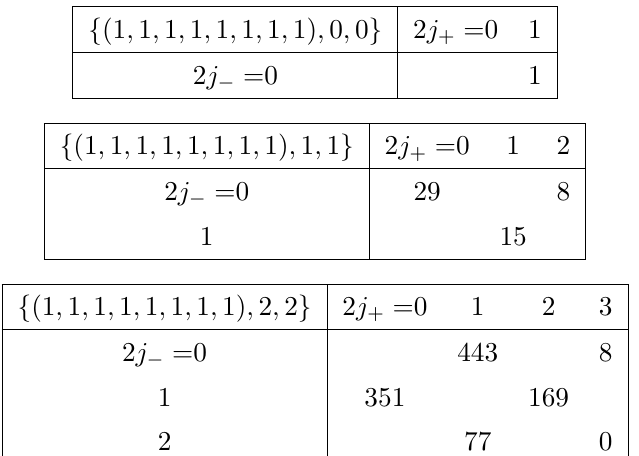
Table 14 . Refined GV invariants from (2,0) E 8 SCFT at base degree (1,1,1,1,1,1,1,1), fiber degree 0, 1 and 2 with mass degree 0, 1 and 2